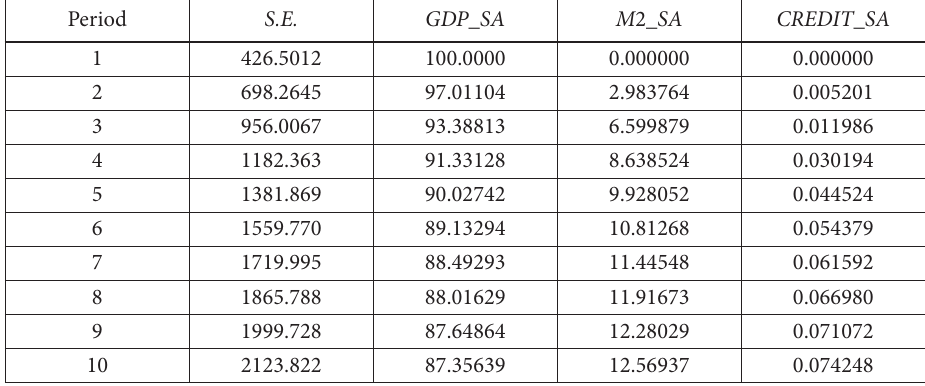
Table 7. Variance decomposition of gross domestic product in Romania (source: authors’